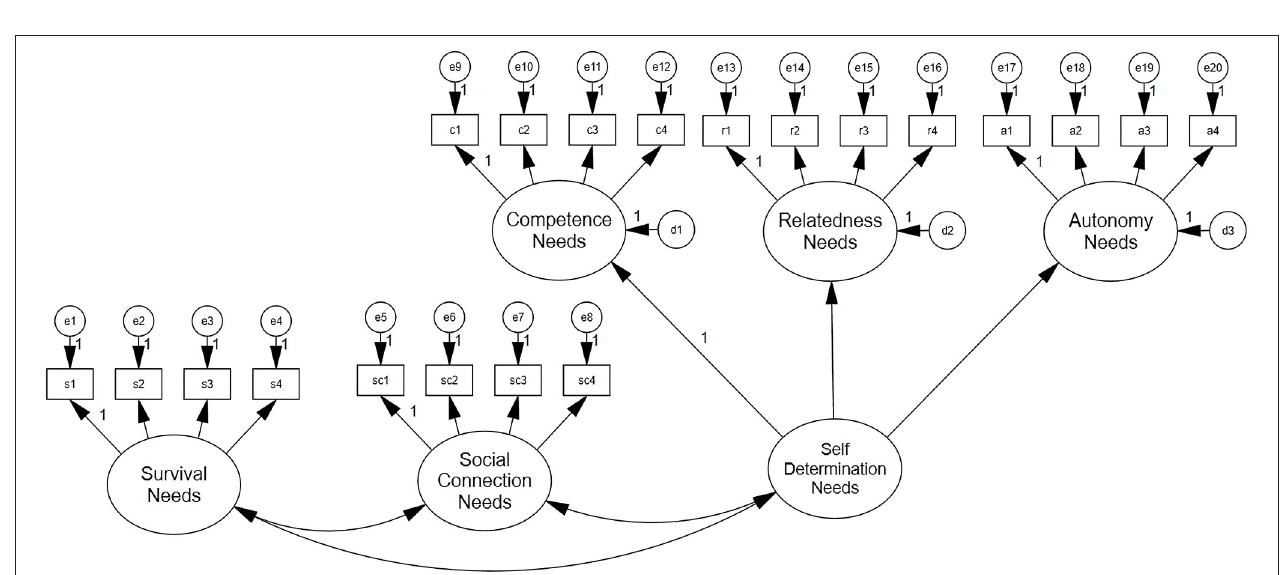
FIGURE 2 | Higher-order model.